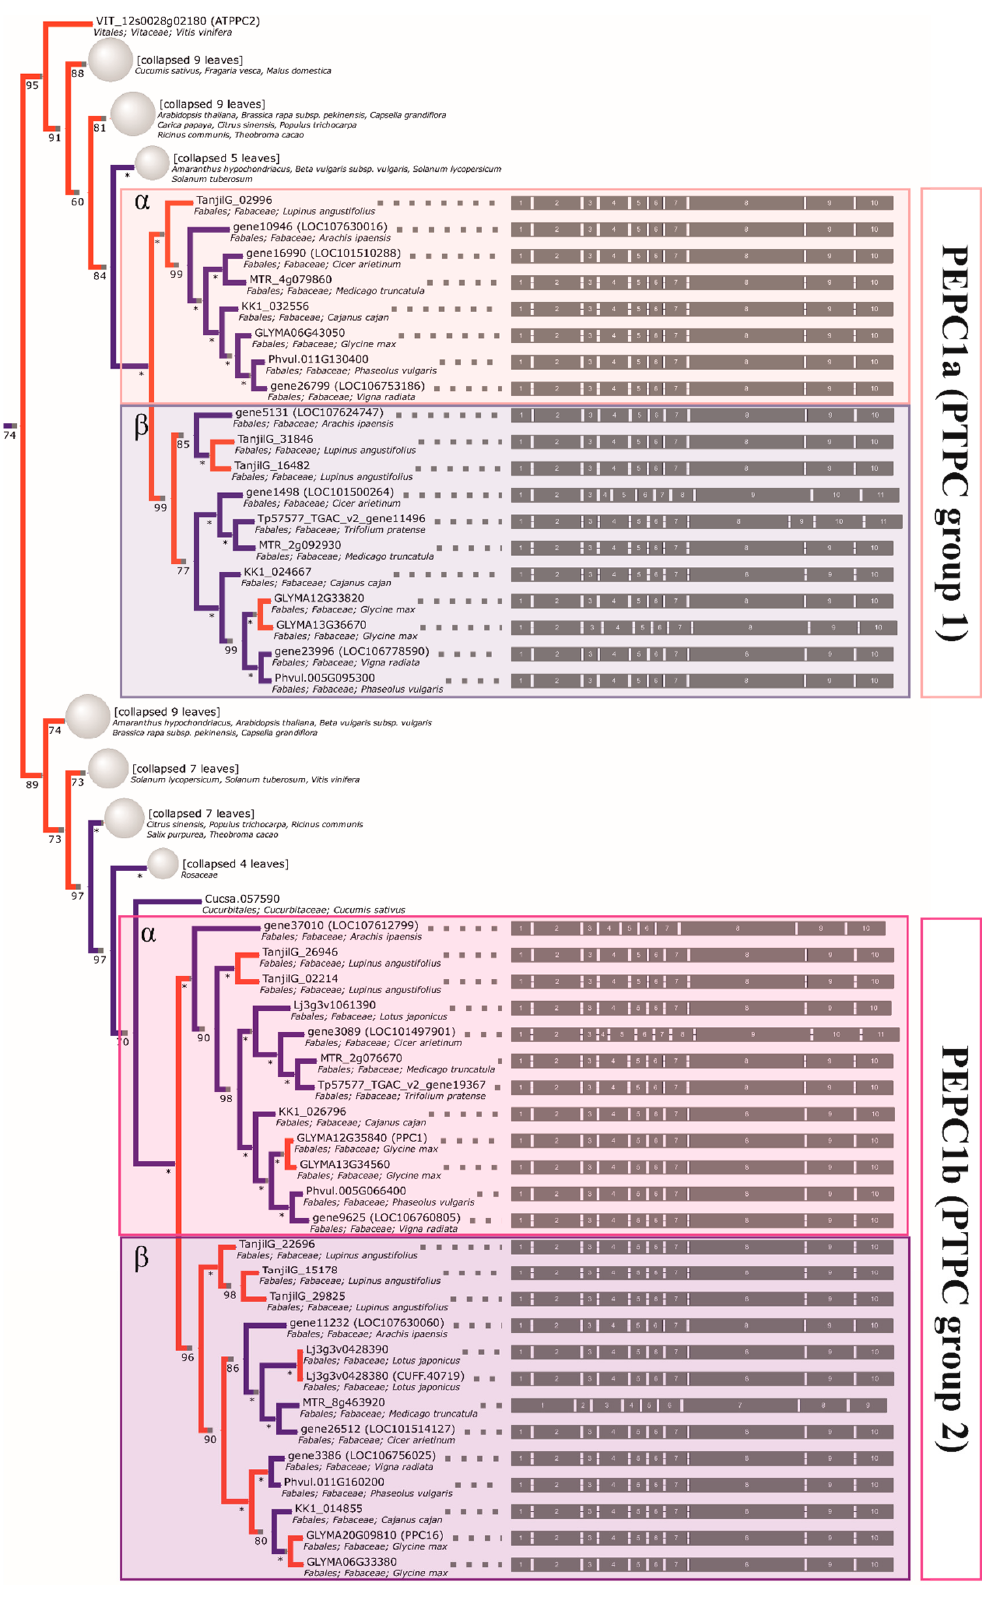
Figure 4. The reconstructed phylogeny of plant PEPC genes. A collapsed phylogeny tree was used in order to highlight Fabaceae family relationships.